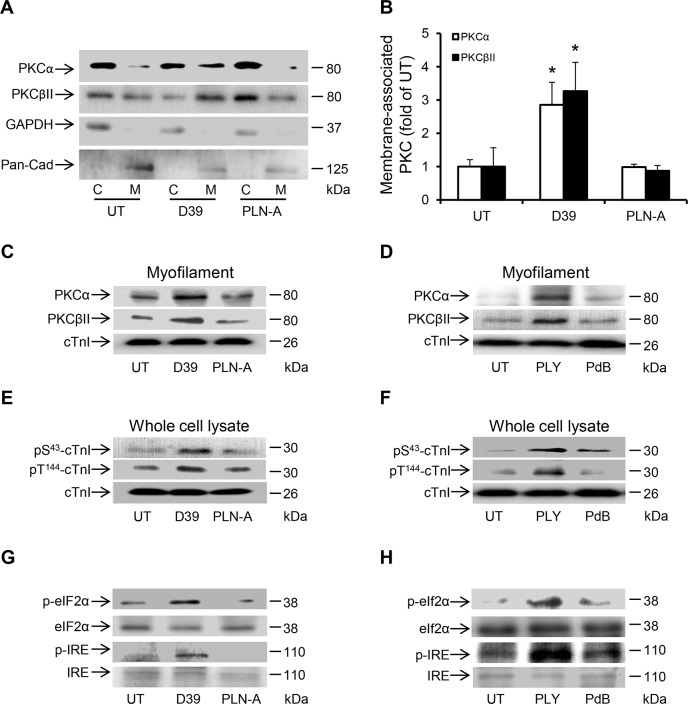
Activation of PKCα-cTnI pathway and ER stress in murine cardiomyocytes exposed to D39 or PLY.(A) Representative Western blots and (B) a band-quantification histogram showing the distribution of PKCα and PKCβII in the cytosol “C” and membrane “M” fractions of murine cardiomyocytes under untreated (UT), D39- and PLN-A-infection (1x106 CFU) conditions (24 h post-infection). GAPDH and Pan-Cadherin were used as markers for “C” and “M” fractions, respectively. Data are presented as Mean±SD (n = 3). * p<0.05. (C) and (D) Typical Western blots showing the effects of D39/PLN-A (1x106 CFU) infection (C) and PLY/PdB (200 ng/g) i.v. injection (D) on the association of PKCα and PKCβII with the myofilament fraction of murine cardiomyocytes 24 h post injection. cTnI was used as an endogenous control (n = 3). (E) and (F) Typical Western blots illustrating the phosphorylation of cTnI at the S43 and T144 phosphorylation sites in murine cardiomyocytes following D39/PLN-A infection (E) and PLY/PdB injection (F) (24 h post injection). cTnI was used as an endogenous control (n = 3). (G) and (H) Typical Western blots showing activation of ER stress markers in murine cardiomyocytes at 24 h post-infection with D39/PLN-A (G) and PLY/PdB (H) (n = 3).